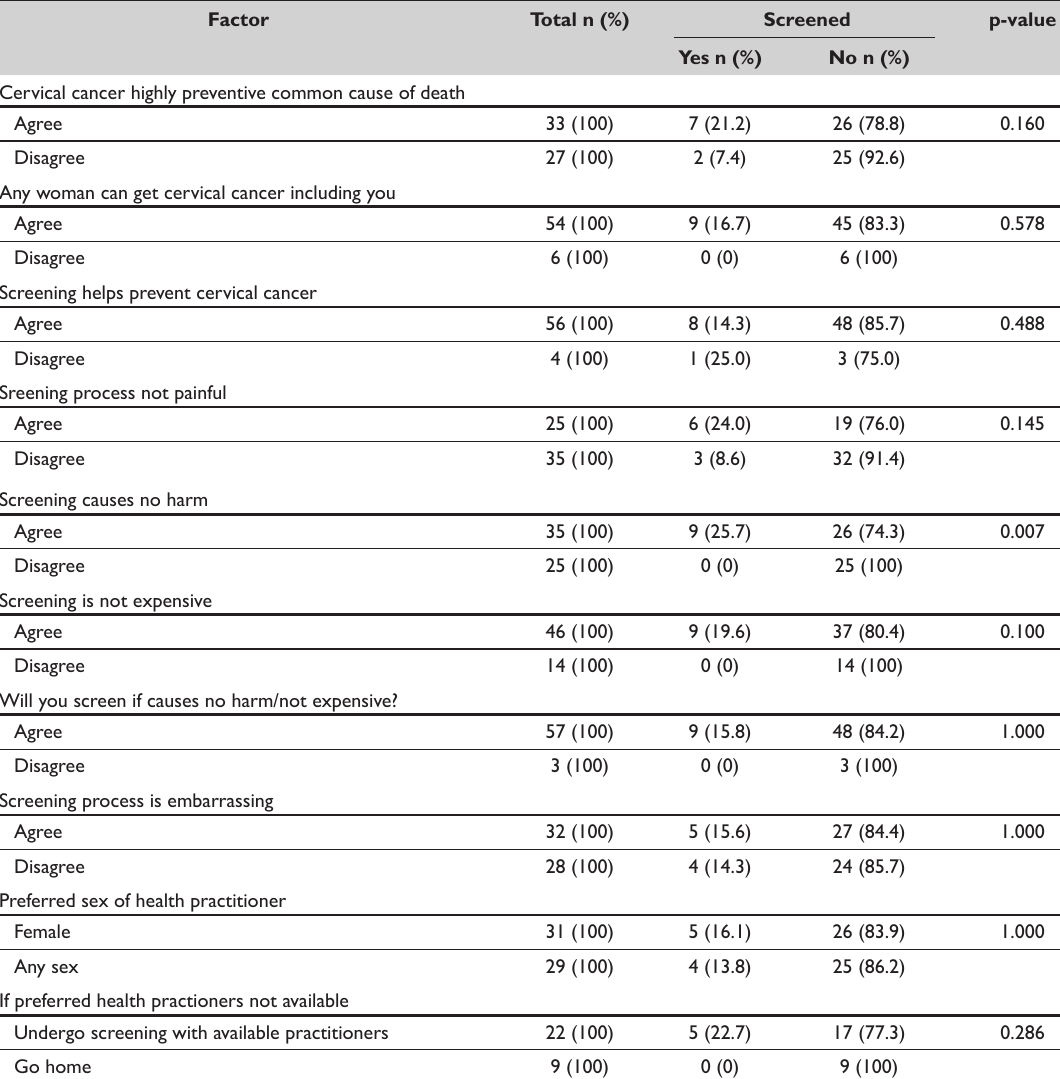
Table 4: Attitude and perception of own risk associated with cervical cancer screening Factor Total n (%) Screened p-value Yes n (%) No n (%) Cervical cancer highly preventive common cause of death Agree 33 (100) 7 (21.2) 26 (78.8) 0.160 27